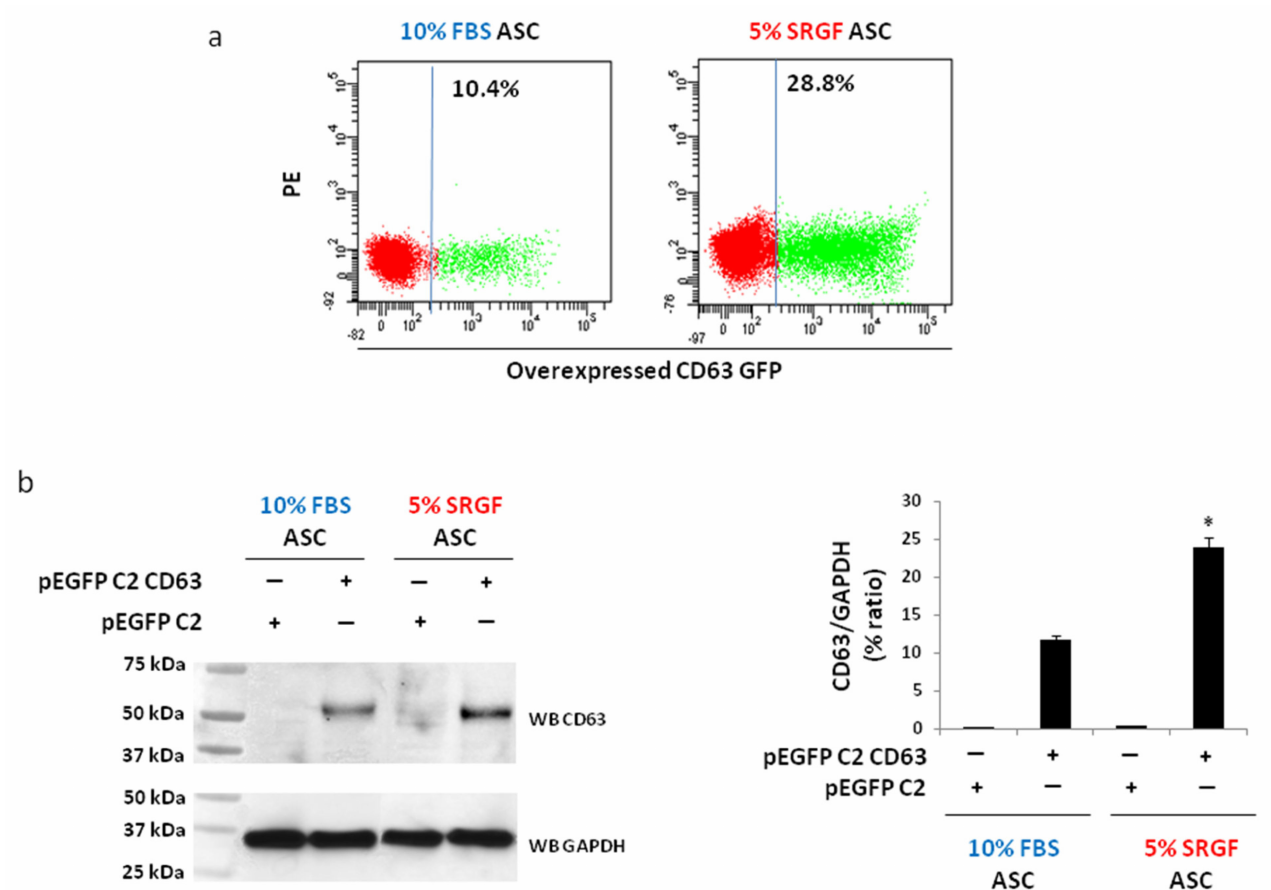
Figure 2. ( a ) reports representative dot plots obtained evaluating GFP positive cells by flow cytometry after NF of a pEGFP C2 vector encoding for CD63 in 10% FBS and 5% SRGF by C17 program. The gating threshold (vertical solid line) identifying GFP negative cells was defined analyzing ASC after NF without DNA vector (as control). ( b ) reports the evaluation by Western blot analysis of CD63 overexpression after NF by C-17 program of a pEGFP C2 vector encoding for CD63. For Western blot analysis, a pEGFP C2 empty vector was transfected (as control condition) in both 10% FBS and 5% SRGF by C17 program. Original unmodified images of analyzed Western blot are reported in Supplementary Figure S1. CD63 band density quantification was expressed as percent ratio to the housekeeping gene GAPDH. *; p < 0.01 vs. 10% FBS ASC. Reported images and quantification values represent results derived from at least three independent experimental